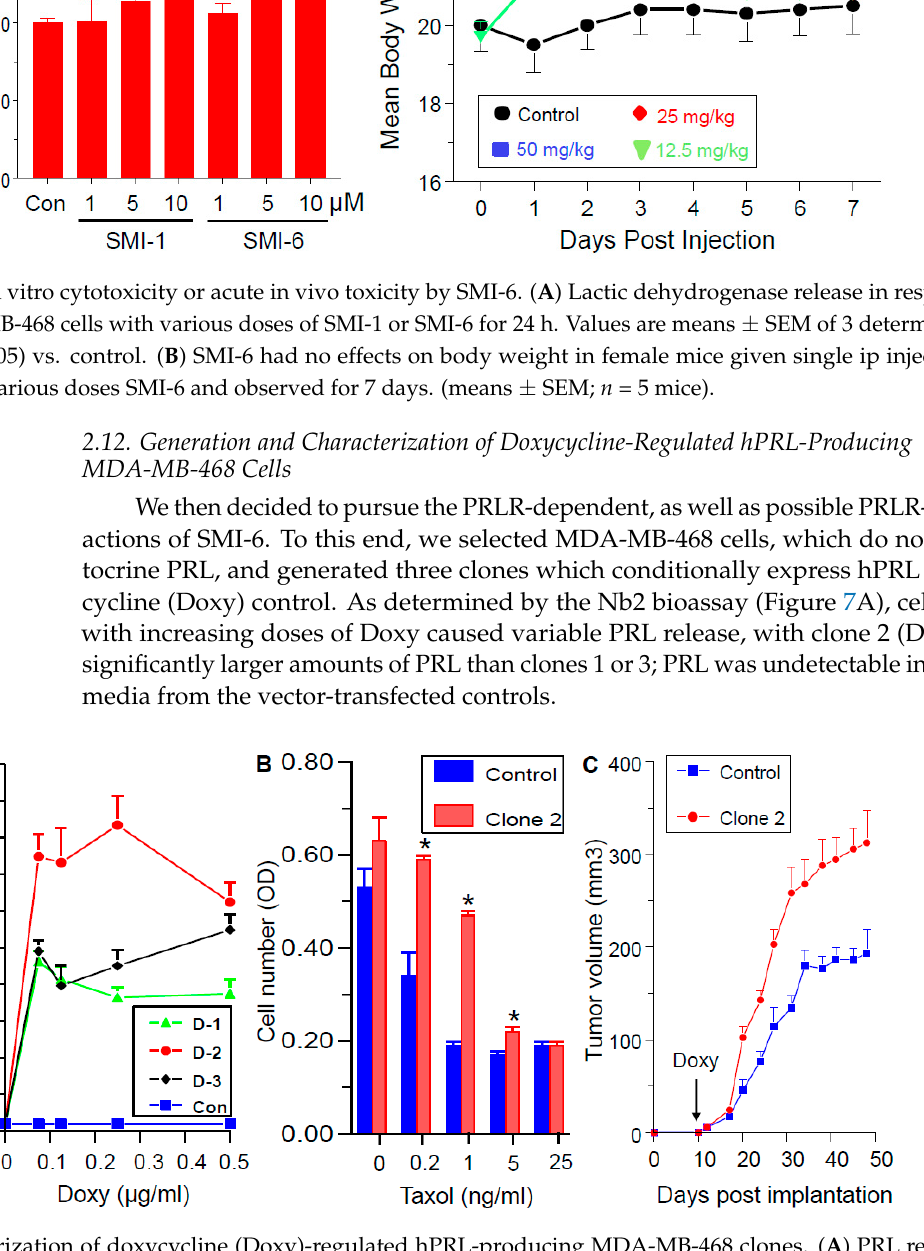
Figure 7. Characterization of doxycycline (Doxy)-regulated hPRL-producing MDA-MB-468 clones. ( A ) PRL release, as determined by the Nb2 bioassay, from three clones (D-1, D-2, and D-3) expressing hPRL under Doxy regulation. Cells were incubated with Doxy for 72 h. Control: vector-transfected clone. Values are means ± SEM ( n = 3). ( B ) Autocrine PRL partially antagonizes the cytotoxic effects of Taxol. Vector-transfected clone (control) and clone 2 were incubated with 0.25 µ g/mL Doxy, with and without various doses of Taxol. Cell viability was analyzed after 4 days by a Resazurin assay. Values are means ± SEM ( n = 3). * significant ( p < 0.05) vs. control. ( C ) Autocrine PRL accelerates tumor growth. Athymic nude mice were inoculated into the inguinal mammary fat pad with vector-transfected clone (control) or clone 2. After 10 days, doxycycline-hyclate was added to the drinking water, followed by measurements of tumor volumes for 50 days. Values are means ± SEM ( n = 5 mice).